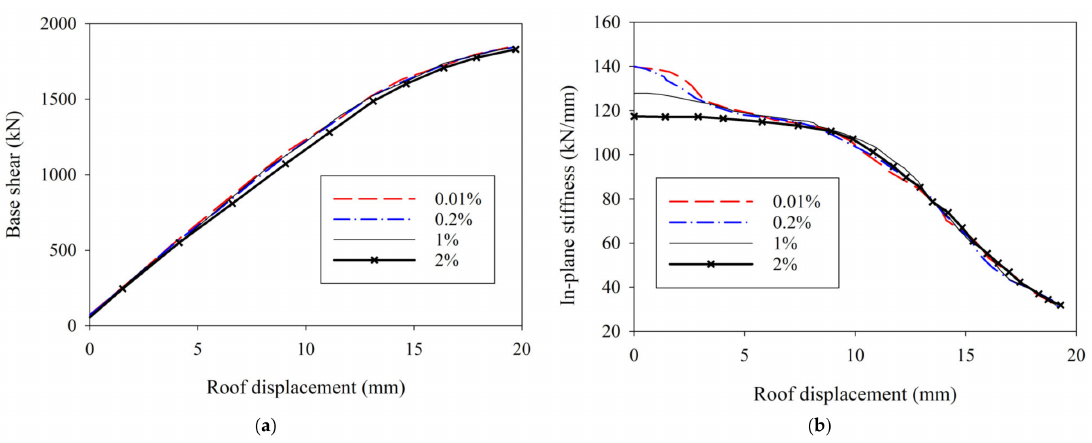
Figure 6. Effect of geometrical imperfection on the behavior of steel plate shear wall system: ( a ) base shear–roof displacement relationship and ( b ) stiffness changes rather than roof